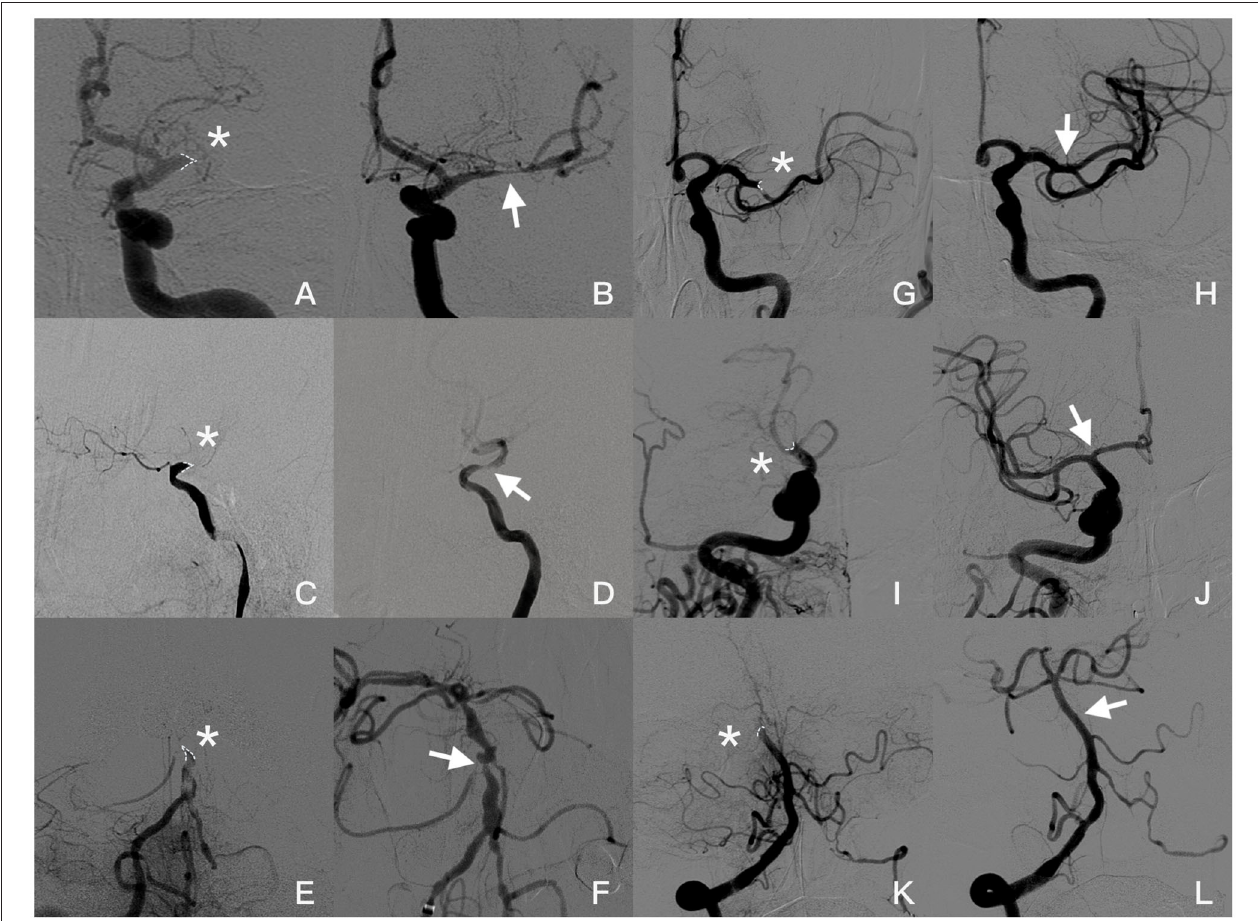
FIGURE 2 | Angiogram images of a patient with jet-like appearance (A–F) : (A,B) Jet-like appearance at the origin of the left MCA in late arterial phase (asterisk). Severe stenosis (arrow) was seen in the MCA after first attempted thrombectomy. (C,D) Occlusion at supraclinoid of ICA presented as a jet-like appearance (asterisk). After the small-volume thrombus was removed, severe stenosis is shown (arrow) after the ophthalmic artery was taken off and forward blood flow was significantly affected. (E,F) Basilar artery occluded at AICA take-off (asterisk). Severe stenosis was seen after two thrombectomy attempts; however, blood flow speed was normal, and no further angioplasty was required. Angiogram images of patients without jet-like appearance (G–L) . (G,H) : Concave appearance of the occluded left MCA (asterisk), and post-thrombectomy angiography showed recanalization of the superior branch of MCA without focal stenosis. (I,J) Occlusion at the end of ICA with concave appearance (asterisk). Both MCA and ACA were recanalized without focal stenosis (arrow). (K,L) Appearance of top of basilar artery occluded (asterisk) and recanalized (arrow) in a female with atrial fibrillation. Occlusion appearance in angiography was figured out by dotted